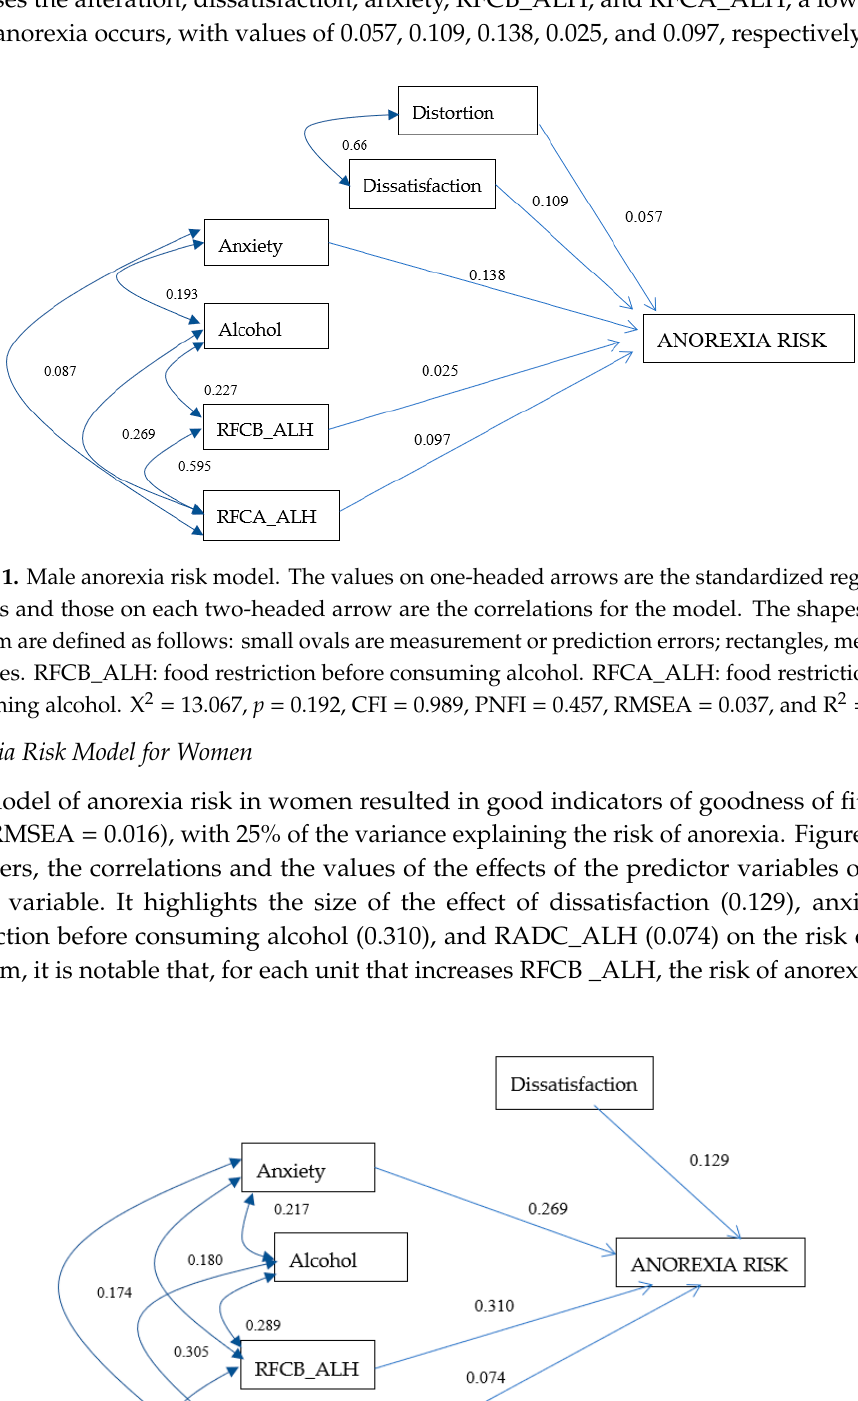
Figure 3. Bulimia risk model for men. The values on one-headed arrows are the standardized regression weights and those on each two-headed arrow are the correlations for the model. The shapes in the diagram are defined as follows: small ovals are measurement or prediction errors; rectangles, measured variables. RFCA_ALH: food restriction after consuming alcohol. X 2 = 14.256, p = 0.075, CFI = 0.977, PNFI = 0.507, RMSEA = 0.055, and R 2 = 0.284.